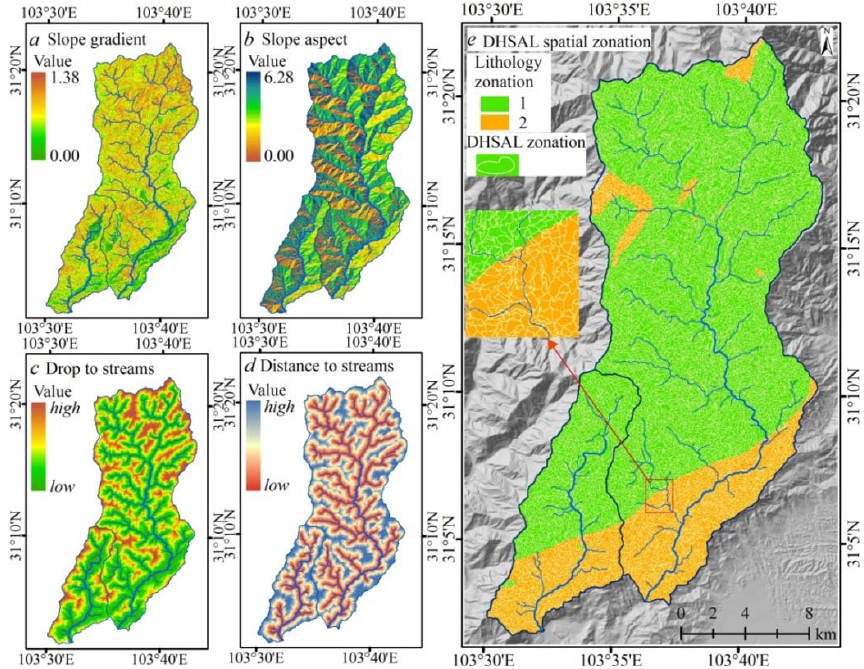
Figure 5. ( a ) Slope gradient map of the study area; ( b ) slope aspect map of the study area; ( c ) drop to the streams map of the study area; ( d ) distance to streams map of the study area; ( e ) DHSAL spatial zonation map of the study